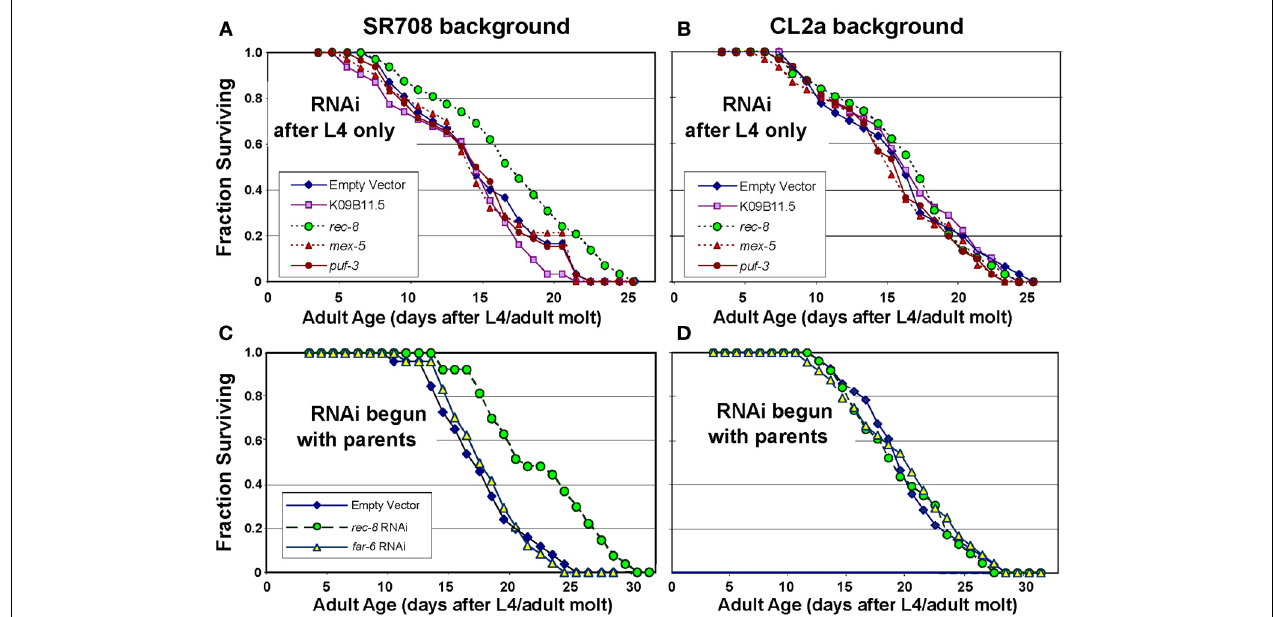
FIGURE 1 | Rec-8 knockdown extends lifespan, dependent on genetic background in the lsq4 region. Groups of 35 worms were fed on bacteria induced to express the indicated dsRNA (or empty expression vector) continuously from the L4/adult molt (A,B) to avoid possible developmental effects, or initiated with the L4/adult molt of the parents of tested worms (C,D) to maximize knockdown. Lifespan survivals were monitored as described (see Methods). Of the indicated genes targeted by